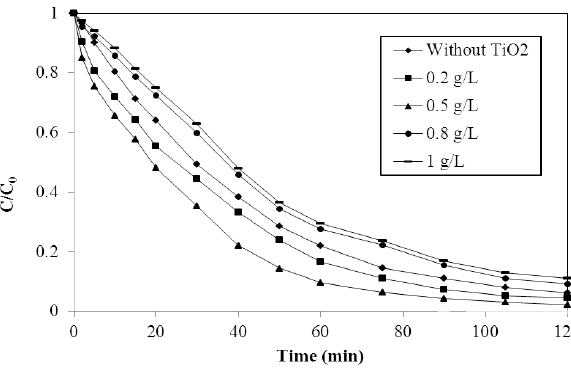
Figure 4: Optical emission spectrum of the glow discharge at 20 mA generated above water in Ar atmosphere.